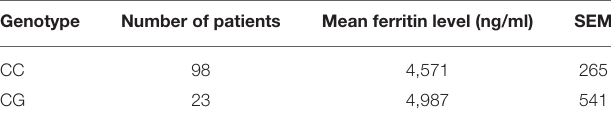
TABLE 2 | Mean serum ferritin levels and genotype of the p .H63D mutation.